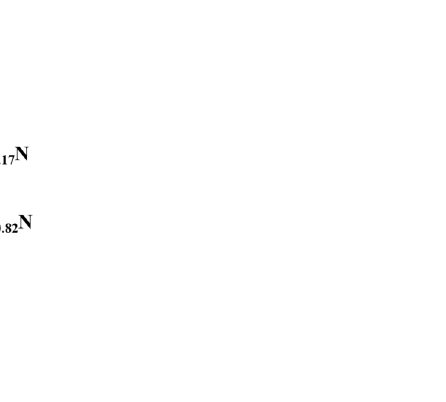
Figure 3. Three-dimensional schematic configuration of MOSHEMTs with multiple-mesa-fin-channel array.